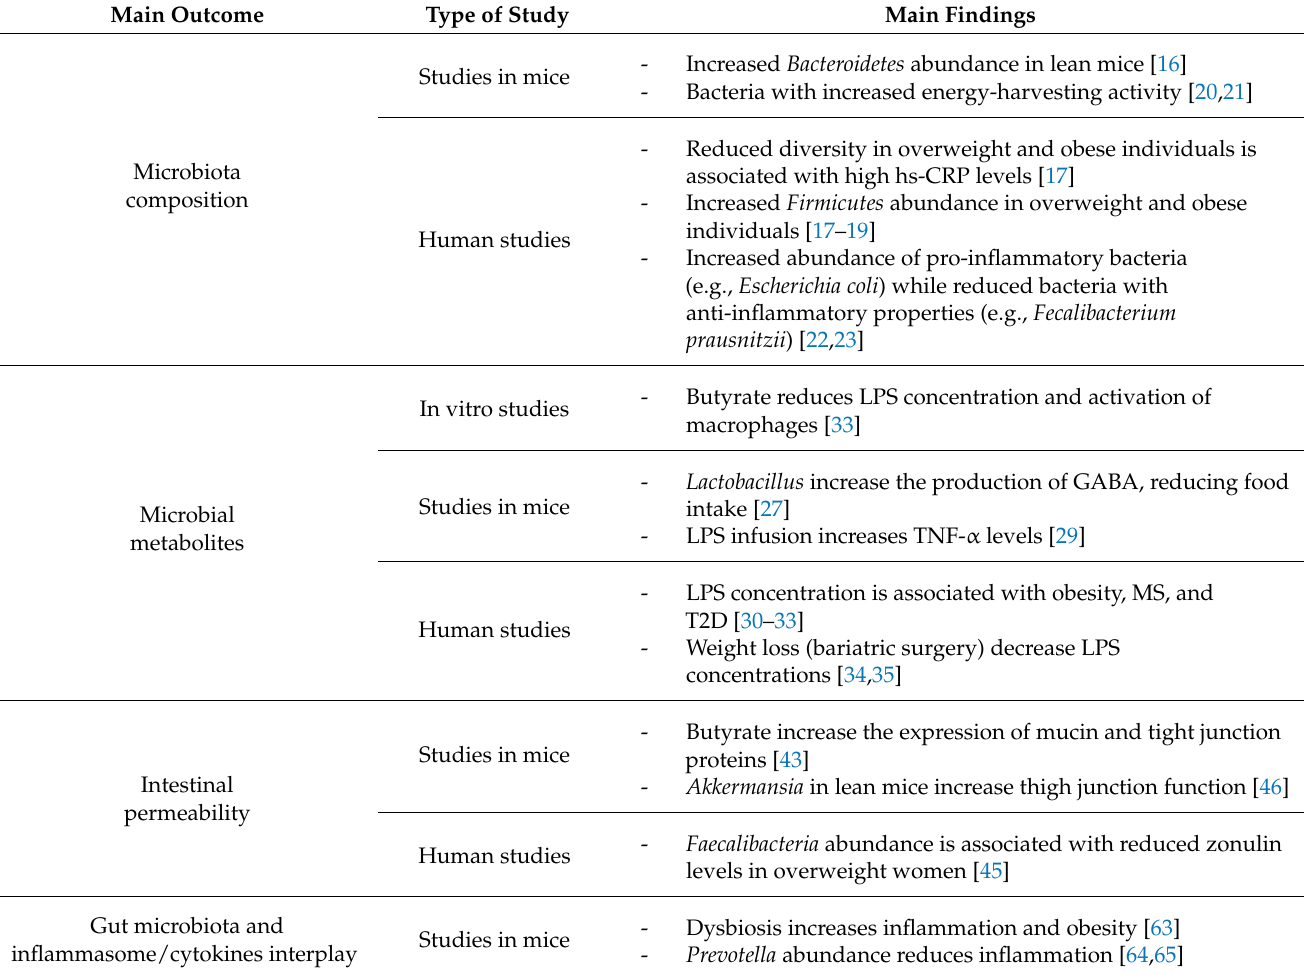
Table 1. Summary table of studies focusing on the association between microbiota composition and